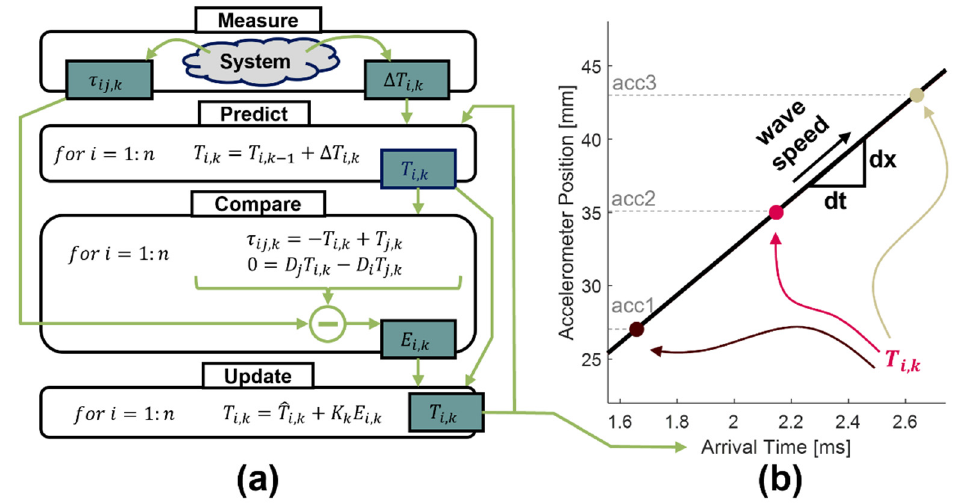
Figure 3. ( a ) Flowchart depicting the iterative Kalman algorithm used to compute wave arrival times at each accelerometer location. ( b ) A weighted least squares regression was used to determine the best wave speed based on the Kalman arrival times. The weights of each arrival time were based on a secondary output of the Kalman filter—the estimated state uncertainty.